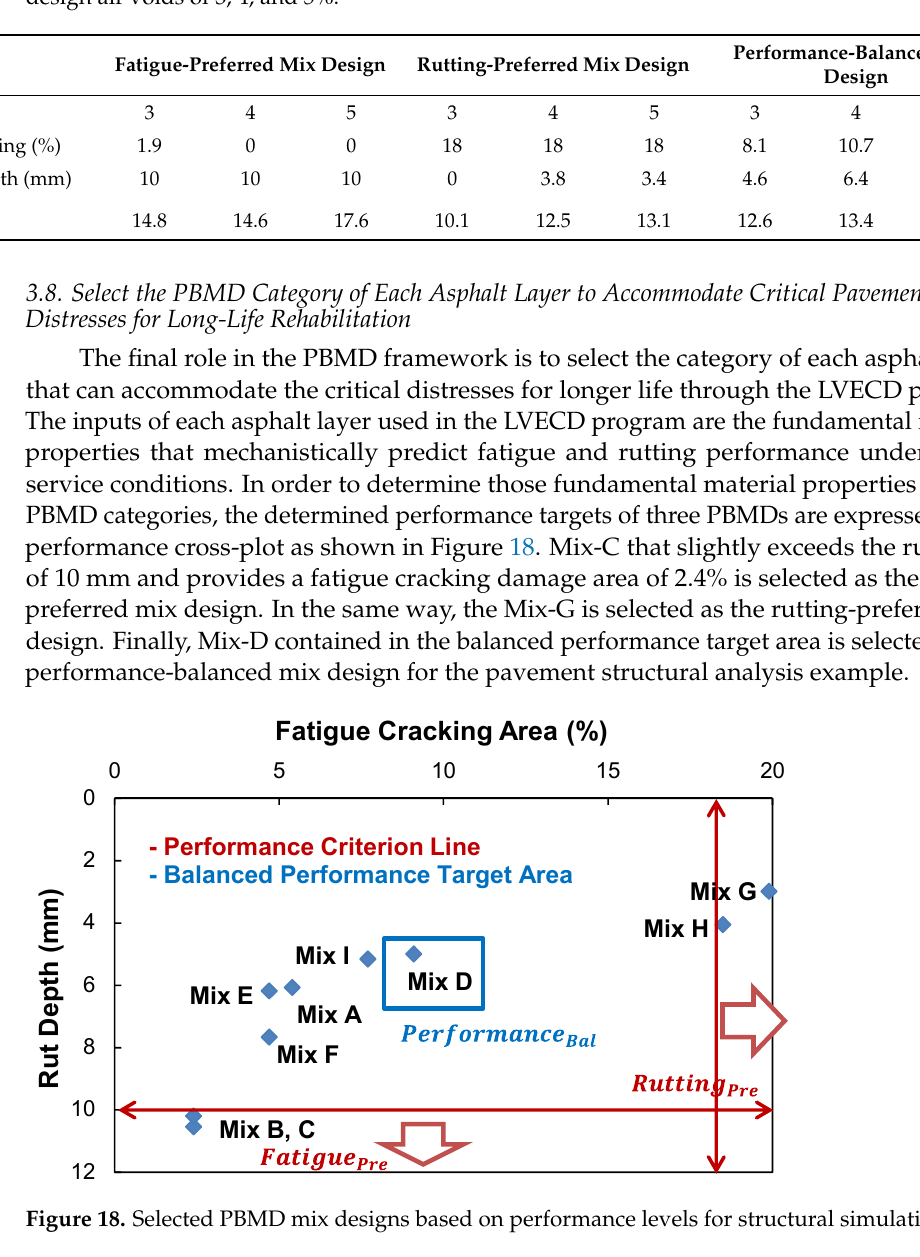
Table 5. Results of the performance targets and their volumetric AQC values of the three PBMDs at design air voids of 3, 4, and 5%.